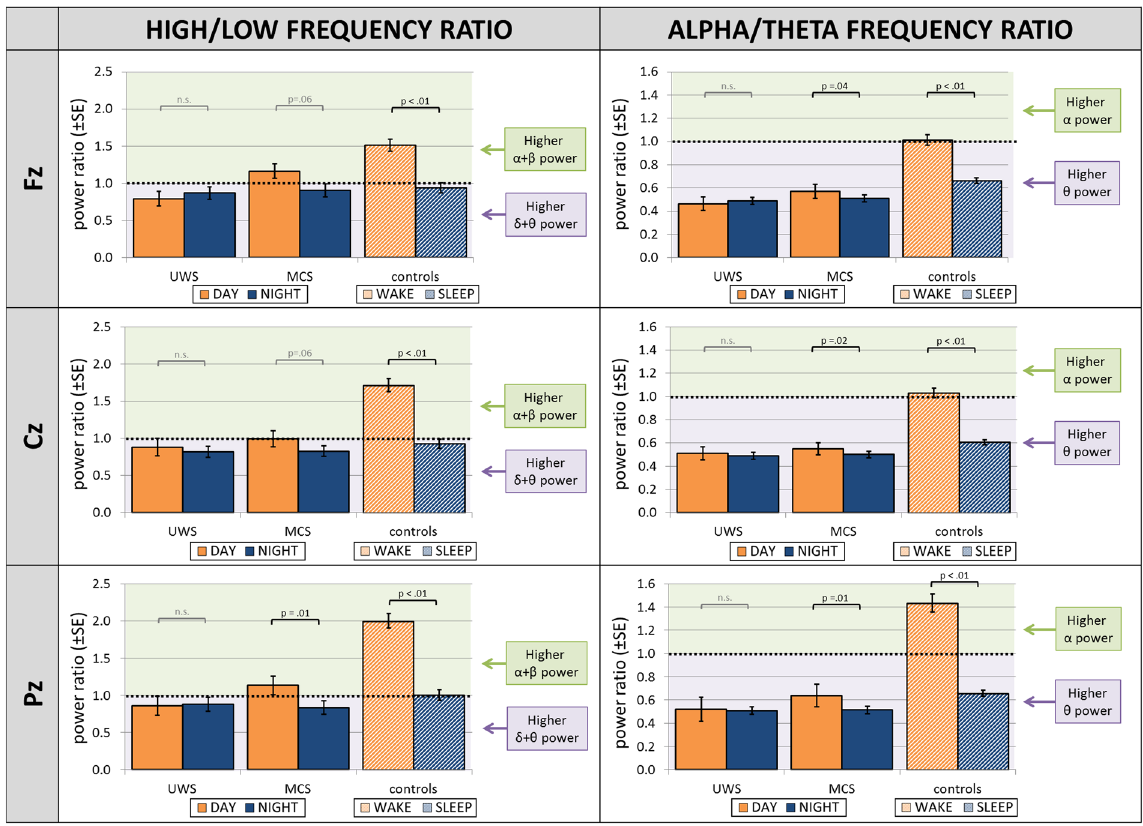
Figure 2. Power spectra ratios across day and night. Both MCS and control subjects revealed statistically significant changes from day to night-time of high-to-low and of alpha-to-theta frequency power ratios, indicating a prevalence of higher frequencies during day-time. No diurnal variation in these measures was observed in UWS patients. High frequencies range from 8–30 Hz, low frequencies range from 2–8 Hz, alpha is defined as 8–12 Hz and theta as 4–8 Hz. Abbreviations: UWS = Unresponsive Wakefulness Syndrome; MCS = Minimally Conscious